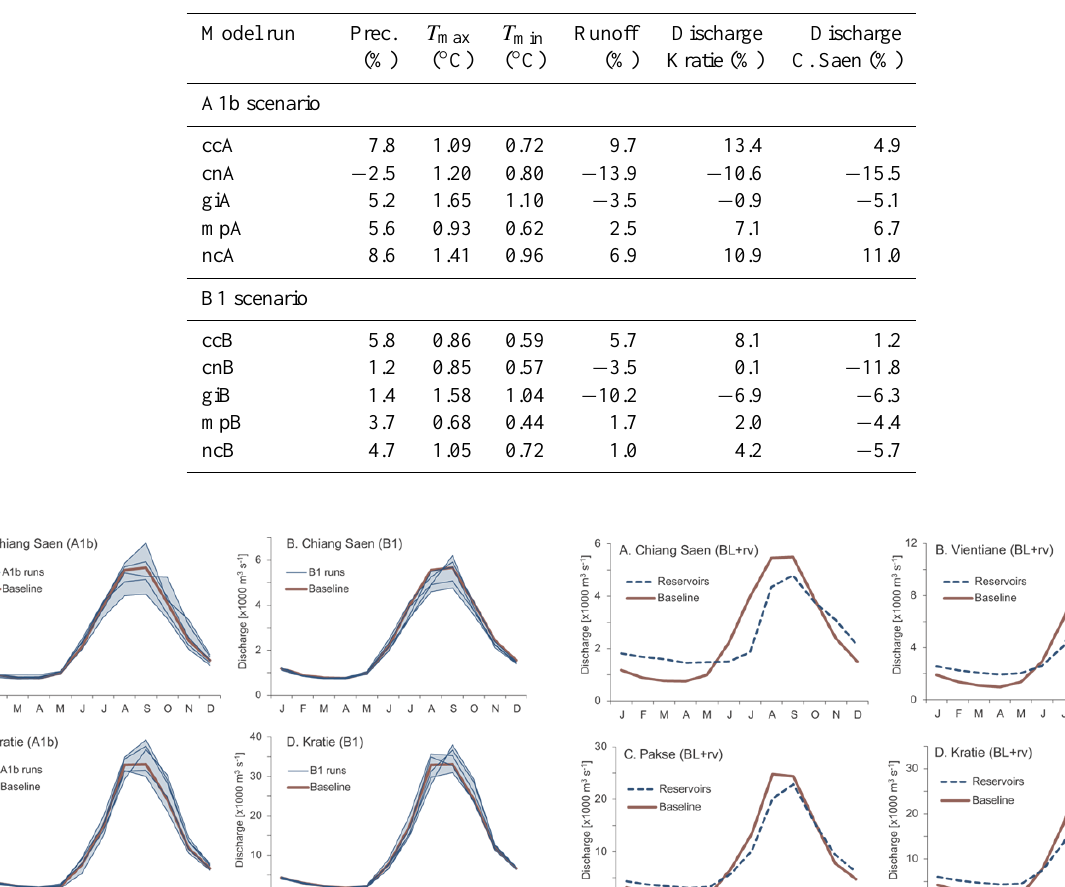
Table 5. Variation in the estimates for the impacts of climate change: changes in average annual precipitation (prec.), maximum temperature ( T max ), minimum temperature ( T min ), and runoff; and annual discharges in Kratie and Chiang Saen for different model runs. Scenario years 2032–2042 are compared to baseline period 1982–1992.